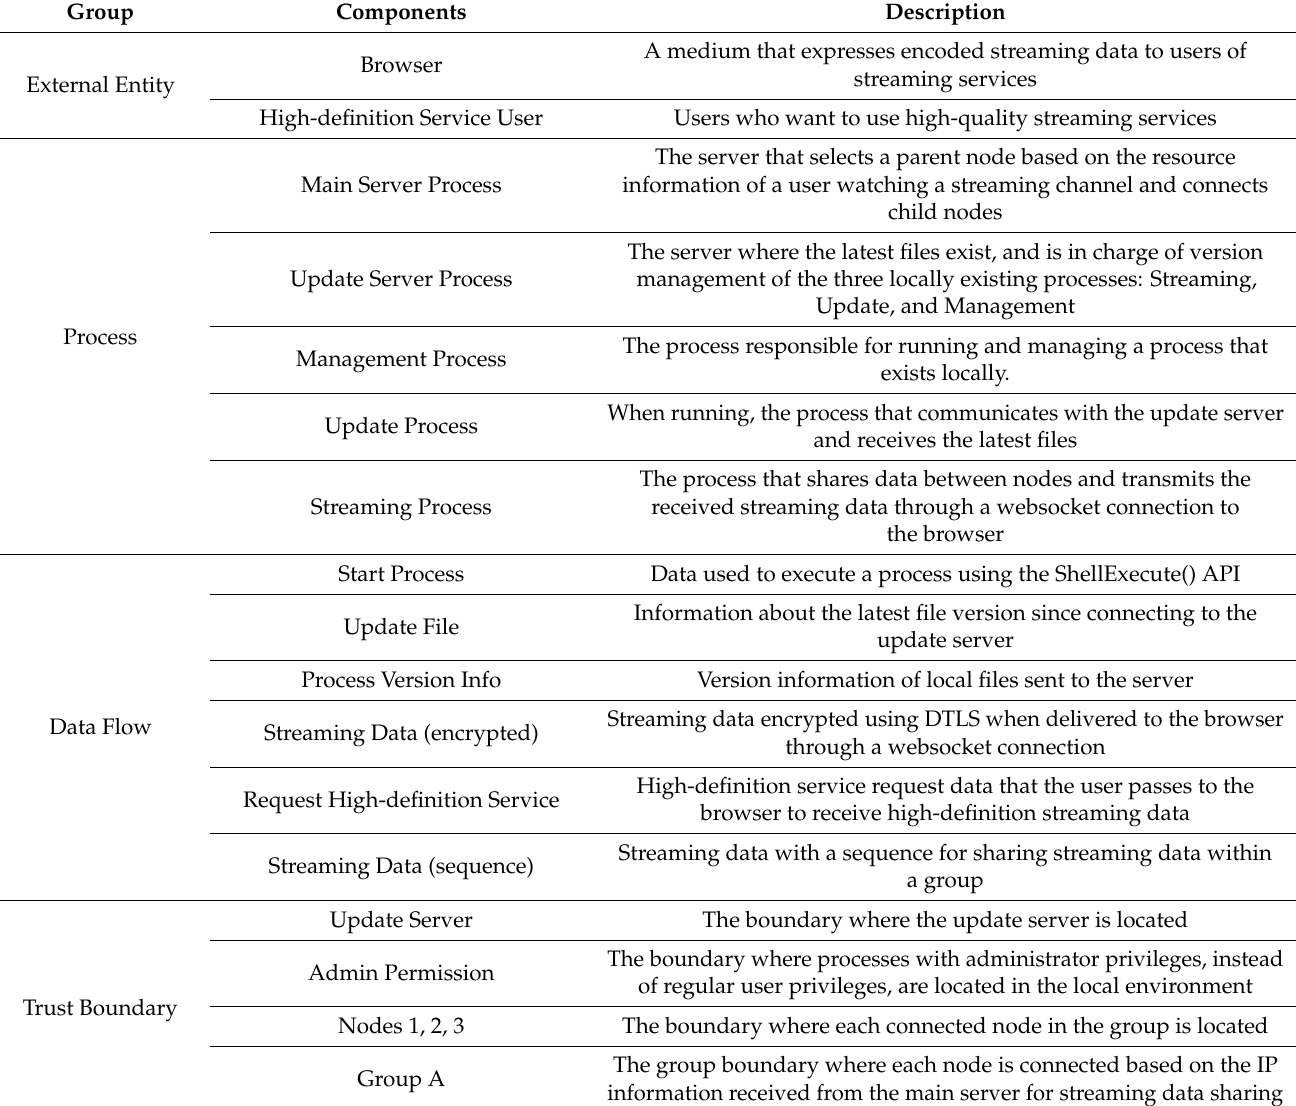
Table A5. Components of mesh-structure-based grid computing system.